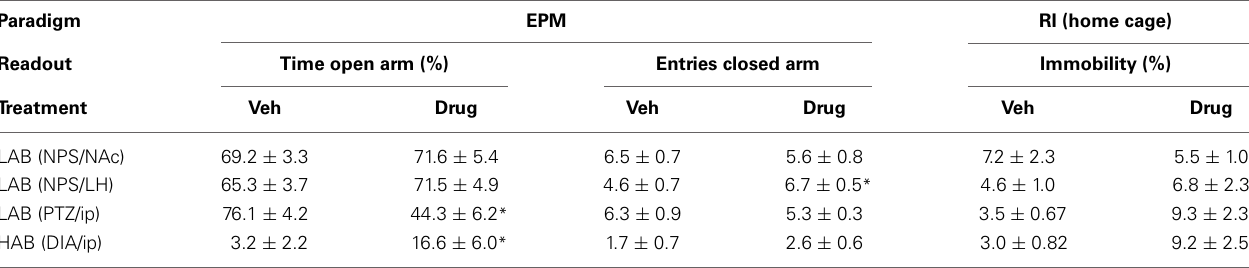
Table 1 | Anxiety-related behavior of LAB, HAB, and NAB rats on the elevated plus-maze (EPM) and home cage immobility during the resident- intruder (RI) test.